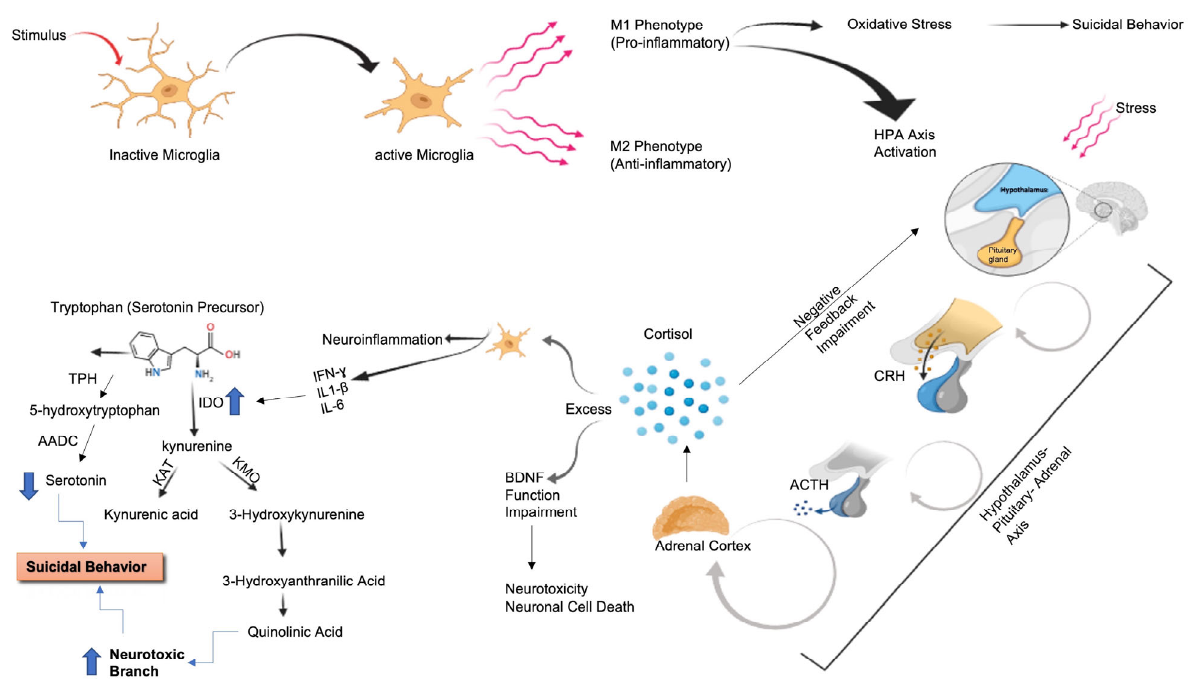
Figure 2. Role of microglia and hypothalamic ‐ pituitary ‐ adrenal ‐ axis in neuroinflammation and suicidality. Emphasis on the kynurenine pathway. (Created in BioRender.com (accessed on 2 April